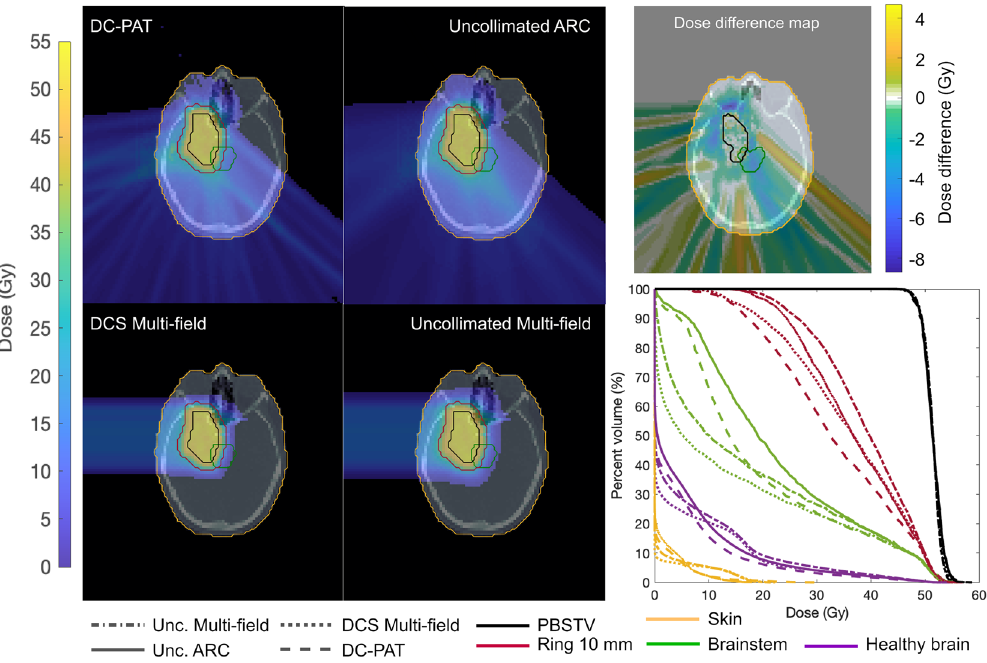
Figure 3. Dose distribution and dose-volume histogram (DVH) from the multi-field and proton arc treatment plans that were delivered with (DCS) and without (Unc) energy-specific collimation. Arc treatment plans ◦ spanned a 140 gantry angle are subdivided into 129 control points where each control point either consisted of a single energy layer (Unc ARC and DC-PAT). A separate plot is presented showing the difference between these two dose distributions. The coverage is shown for the pencil beam scanning target volume (PBSTV), 10mm ring of healthy tissue surrounding the PBSTV (Ring 10mm), brainstem, and the healthy brain.